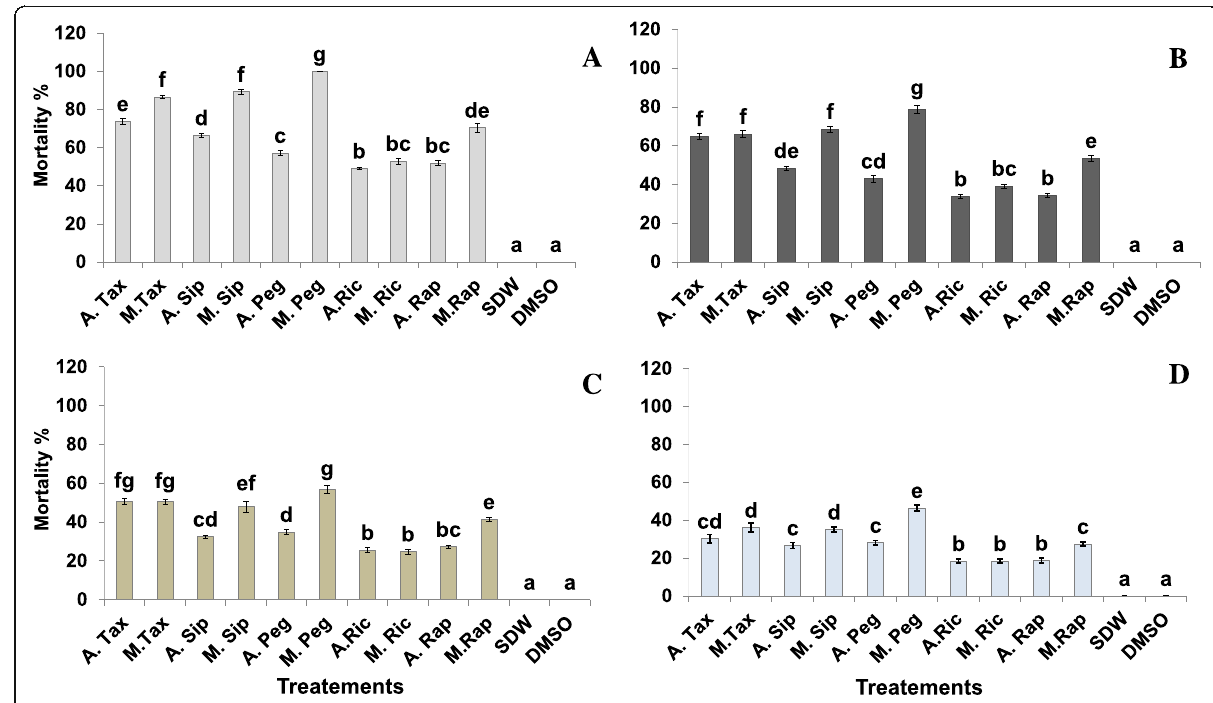
Fig. 1 Effect of different aqueous (A) and methanolic (M) extracts at various concentrations ( a 80%, b 60%, c 50%, and d 40%) on mortality of Meloidogyne incognita juveniles (J2s) after 32 h. Tax T. baccata , Peg . P. harmala , Sin . S. arvensis , Rap . R. raphanistrum , Ric R. communis , SDW sterile distilled water, DMSO